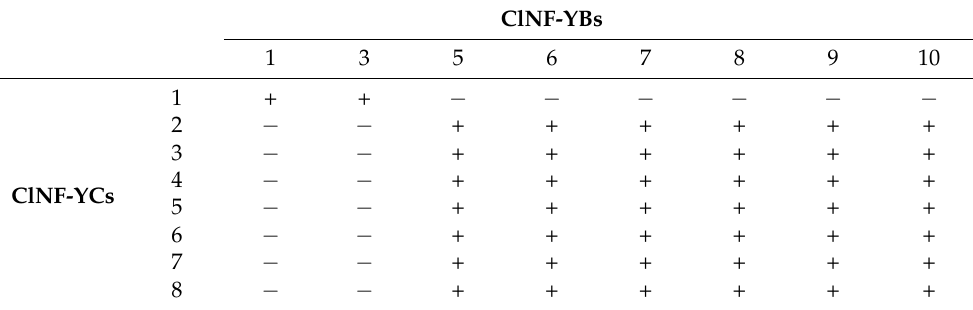
Table 2. Summary of the interactions between ClNF-YBs and ClNF-YCs in BiFC assays. ClNF-YBs 1 3 5 6 7 8 9